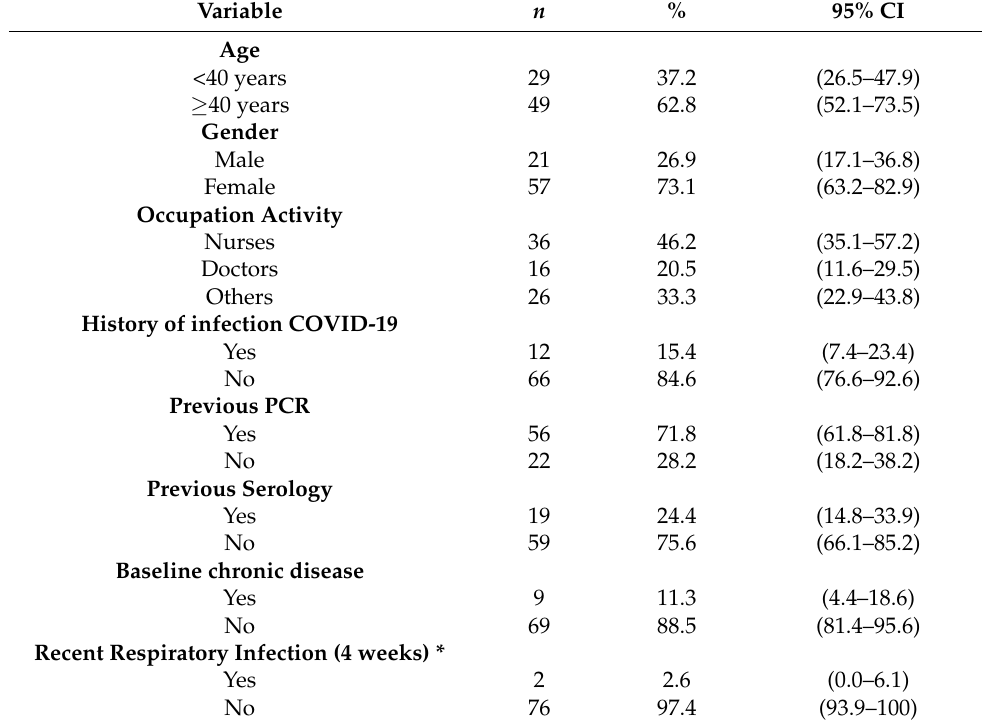
Table 1. Socio-demographic and clinicopathological characteristics of the subjects included in this study.